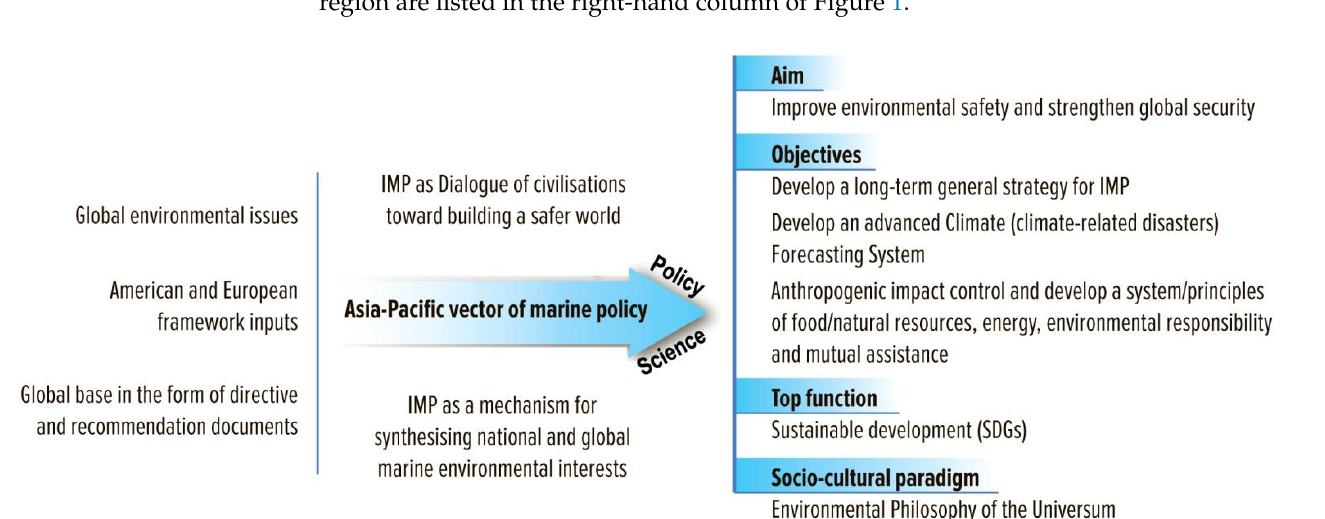
Figure 1. A visual representation of the conceptual model used to apply global experience with Integrated Marine Policy (IMP) to the Asia-Pacific region.